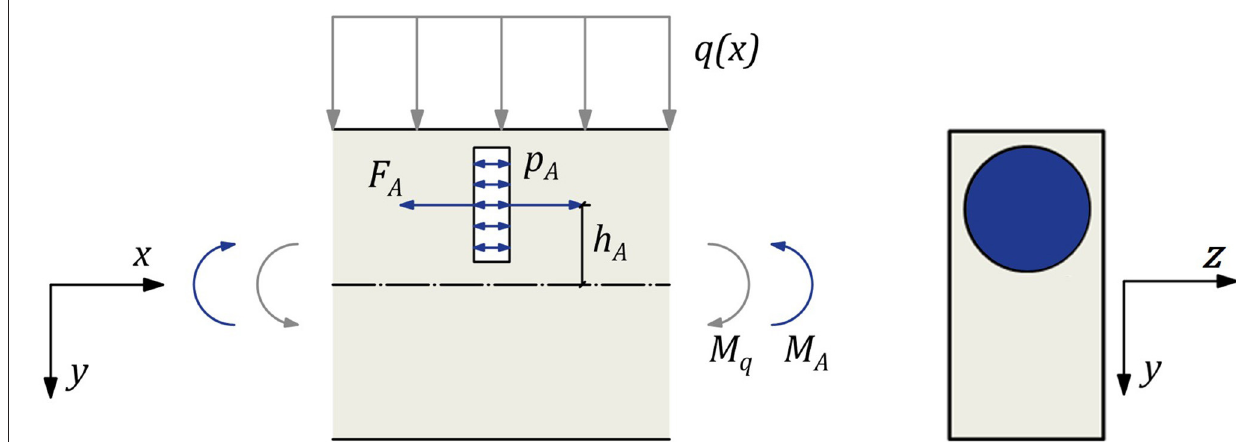
FIGURE 2 | Detail of a beam with one actuator.